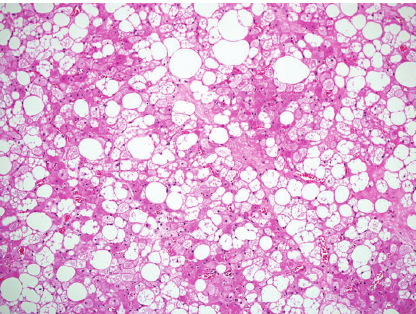
Figure 5: Hibernoma. Photomicrograph of the excision specimen shows a hibernoma with typical features of a prominent mixture of adipocytes of fetal type. There are only a few scattered large mature univacuolated adipocytes, but numerous multivacuolated adipocytes and smaller polygonal cells with abundant cytoplasm containing finely granular eosinophilic cytoplasm or numerous lipid vacuoles. Haematoxylin and eosin, ×